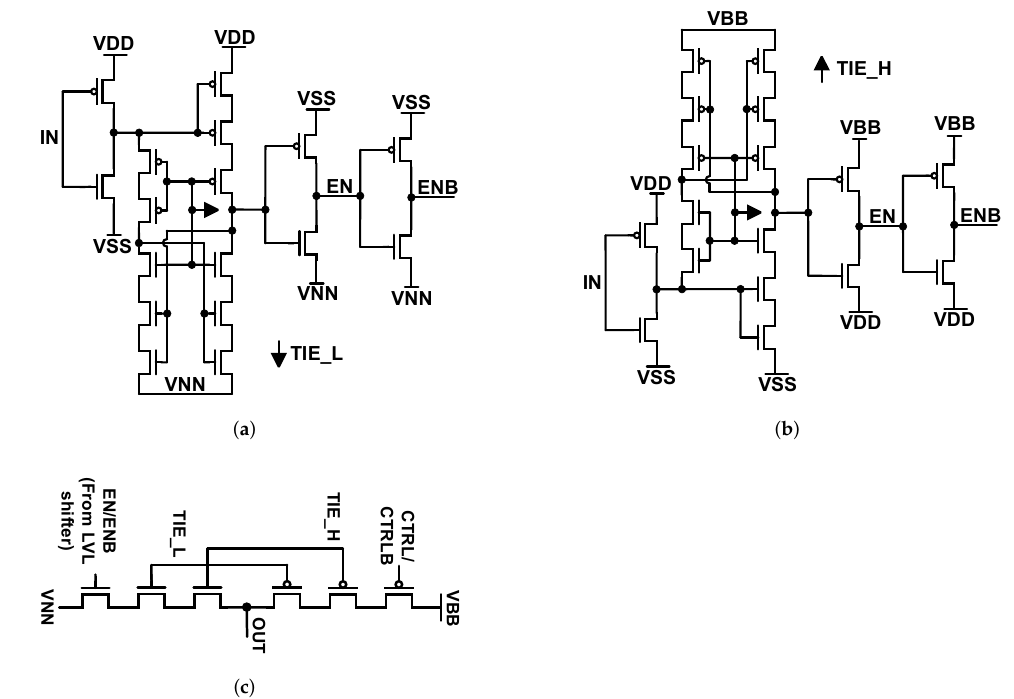
Figure 14. ( a ) Negative level shifter, ( b ) boost level shifter and ( c ) driver structure.